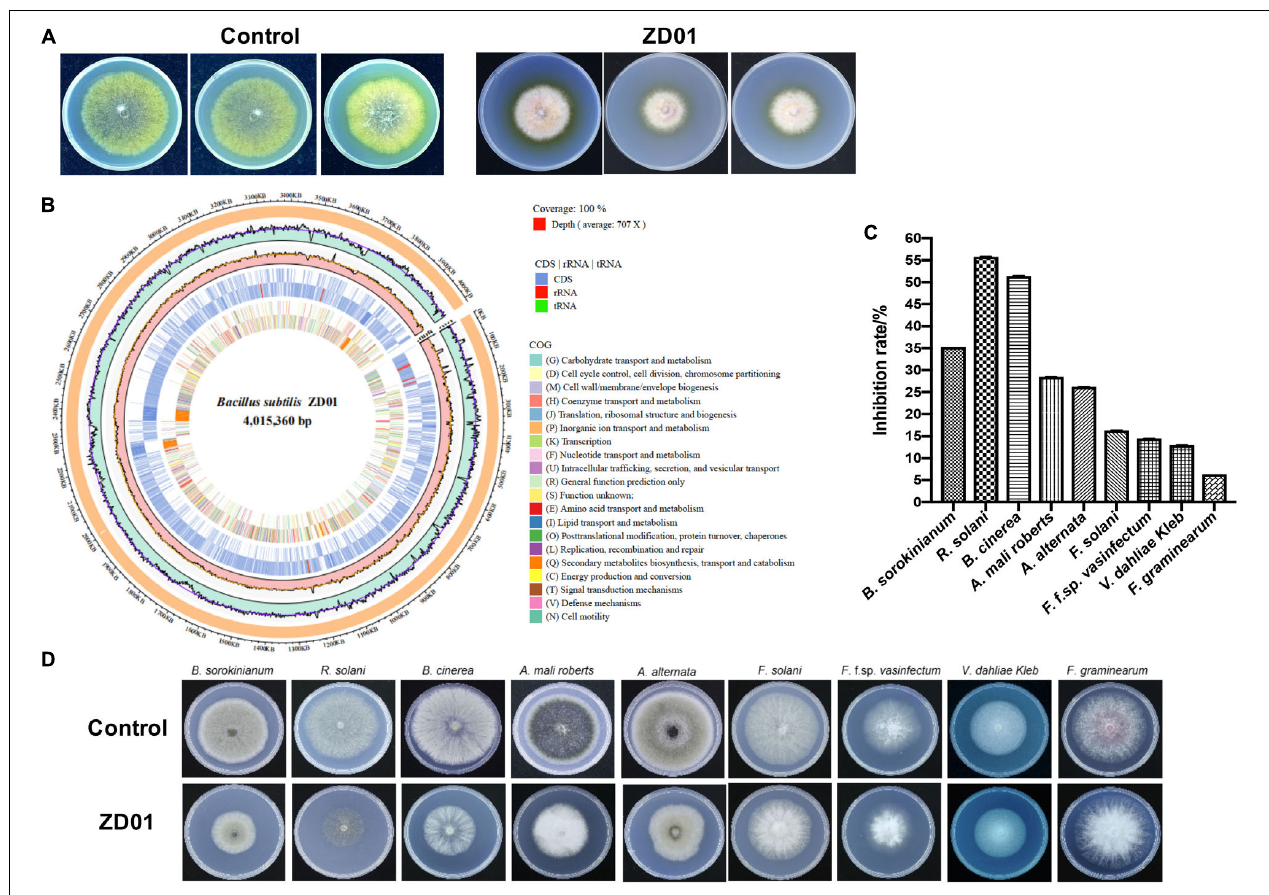
FIGURE 1 | Isolation and identification of ZD01 volatiles for A. solani control. (A) Antagonistic activity of ZD01 volatiles against A. solani . (B) The circularized genome map of Bacillus subtilis ZD01. (C,D) Antagonistic activity of VOCs produced by ZD01 against nine plant pathogens, including Bipolaris sorokinianum , Rhizoctonia solani , Botrytis cinerea , Alternaria mali roberts , Alternaria alternata , Fusarium solani , Fusarium oxysporum f. sp. v asinfectum , Verticillium dahliae Kleb , and Fusarium graminearum. Control represents A. solani without treatment of ZD01 VOCs; ZD01 represents A. solani with treatment of ZD01